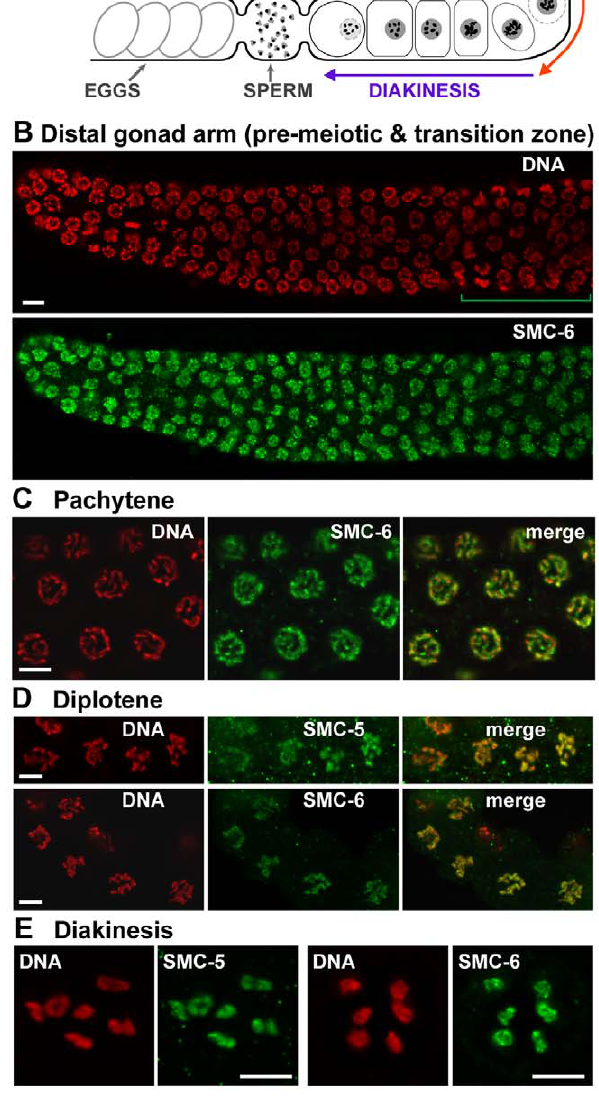
Figure 2. SMC-5 and SMC-6 accumulate in germ cells and on meiotic chromosomes. (A) A drawing representation of an adult hermaphrodite gonad arm. The progression of germ cell proliferation and meiosis are indicated by the arrows starting from the distal tip region of the gonad arm. (B) SMC-6 staining was detected in the nucleus of germ cells in the distal gonad arm. Mitotic germ nuclei are located in the pre-meiotic region proximal to the distal tip. Pre-meiotic S phase nuclei should be located proximal to the transition zone nuclei [66]. The green bracket marks the transition zone region. (C) SMC-6 staining in pachytene nuclei appeared to accumulate on chromosomes, which differed from the more diffuse nucleoplasmic staining in the distal gonad arm in (B). In the diplotene (D) and diakinesis (E) stages of meiotic prophase I, SMC-5 and SMC-6 staining were detected exclusively on chromosomes. Scale bars=5 m